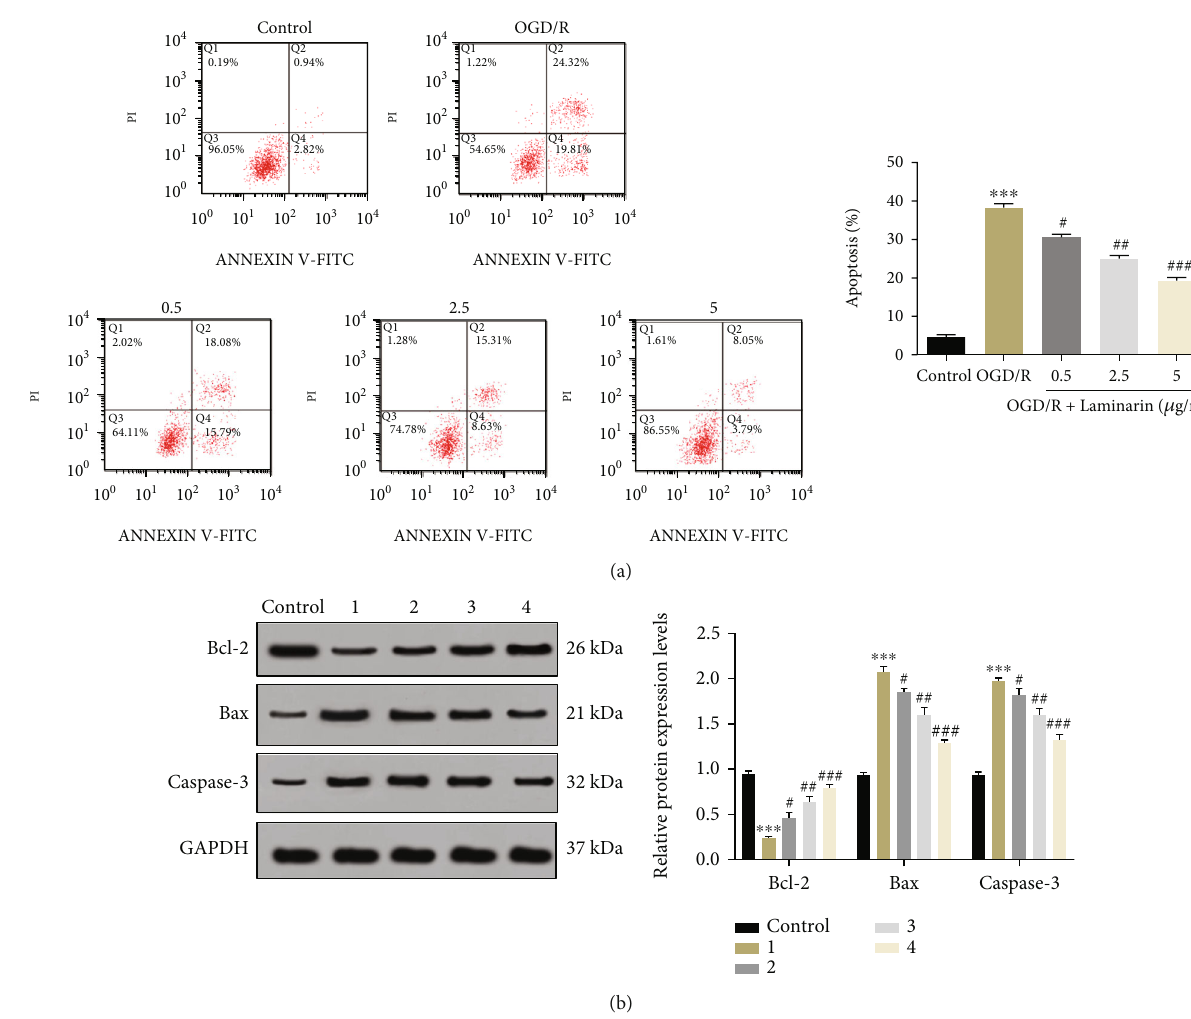
Figure 4: E ff ect of di ff erent concentrations of laminarin (0.5, 2.5, and 5 μ g/ml) on the apoptosis of PC12 cells induced by OGD/R. (a) Flow cytometry was used to detect the e ff ects of di ff erent concentrations of laminarin (0.5, 2.5, and 5 μ g/ml) on apoptosis of PC12 cells induced by OGD/R. (b) Western blot assay was performed to detect the e ff ects of di ff erent concentrations of laminarin (0.5, 2.5, and 5 μ g/ml) on the protein expression levels of Bcl-2, Bax, and Caspase-3 in PC12 cells induced by OGD/R. Note: 1: OGD/R group, 2: OGD+0.5 μ g/ml laminarin group, 3: OGD+2.5 μ g/ml laminarin group, and 4: OGD+5 μ g/ml laminarin group. Compared with the control group, ∗∗∗ P < 0 : 001 ; compared with the OGD/R group, # P < 0 : 05 , ## P < 0 : 01 , and ### P < 0 : 001